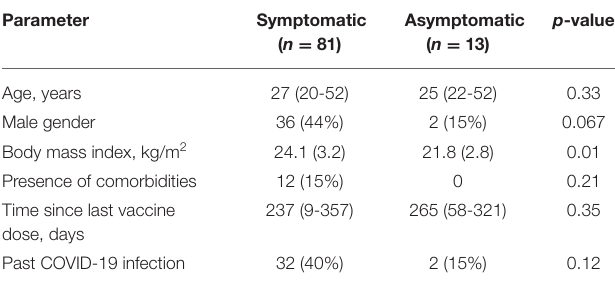
TABLE 3 | Risk factors for symptomatic COVID-19 in the third wave among healthcare